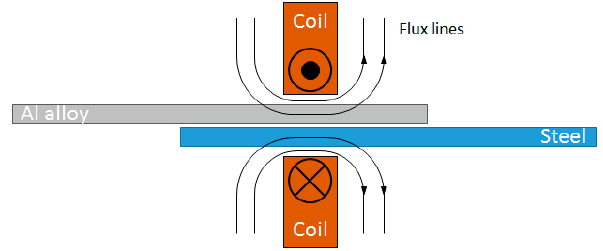
Figure 12. Magnetic pulse welding between steel and aluminum.